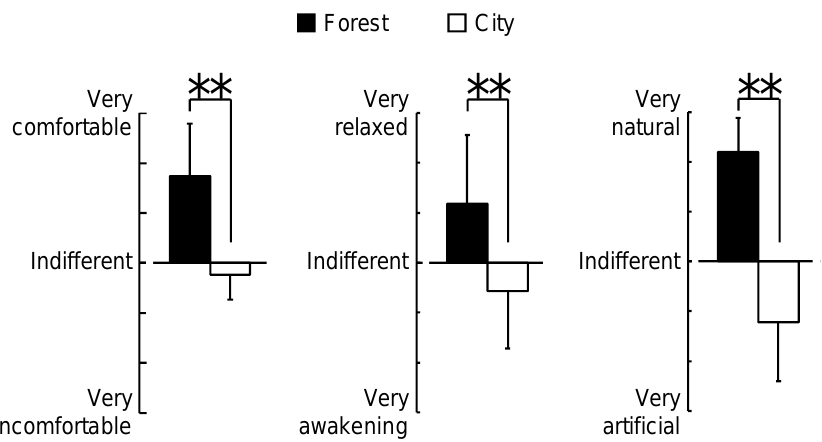
Figure 5. Subjective feelings after walking in forest and city areas, assessed using the modified semantic differential method. Data are shown as means ± standard deviation (n = 60). ** p < 0.01, Wilcoxon signed-rank test (one-sided).